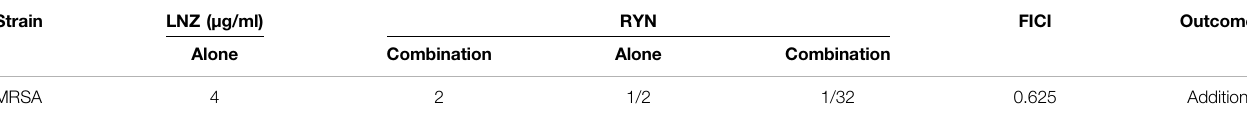
TABLE 2 | The MICs, FICI and action mode of LNZ and RYN on MRSA. Strain